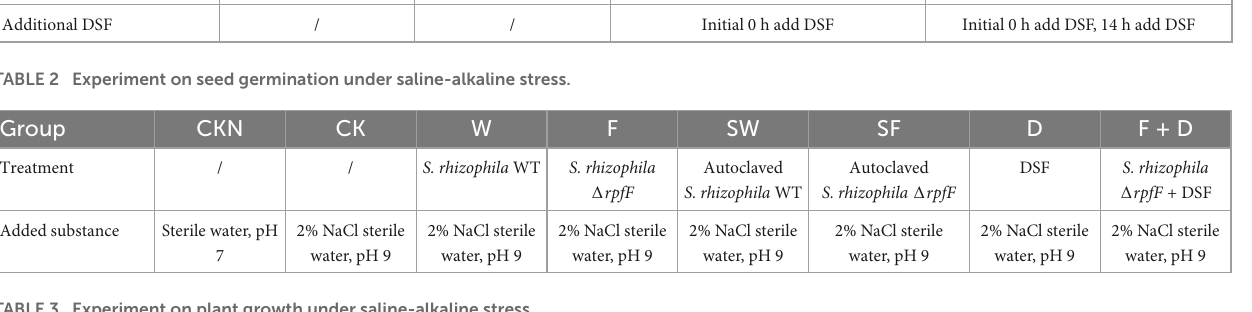
TABLE 3 Experiment on plant growth under saline-alkaline stress.